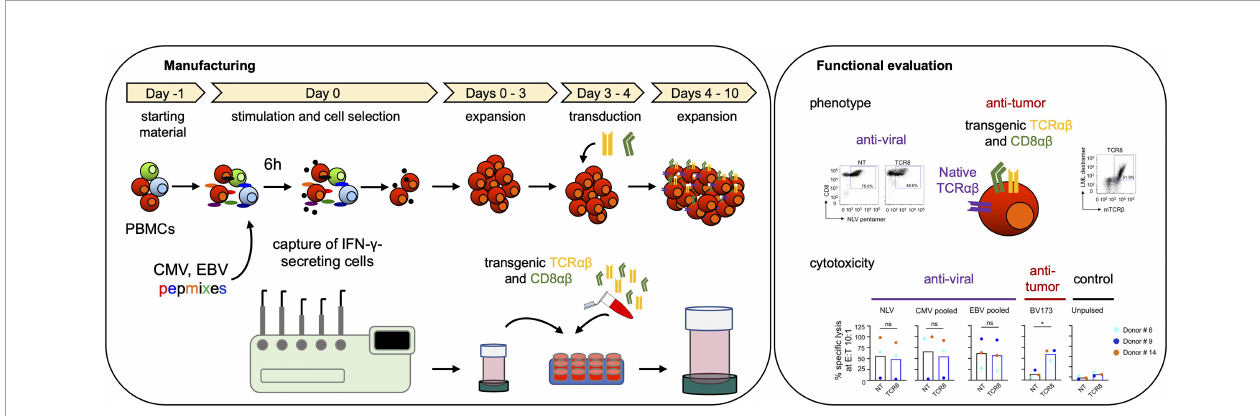
FIGURE 5 | Schematic overview of transgenic virus-speci fi c T cell manufacturing and functional